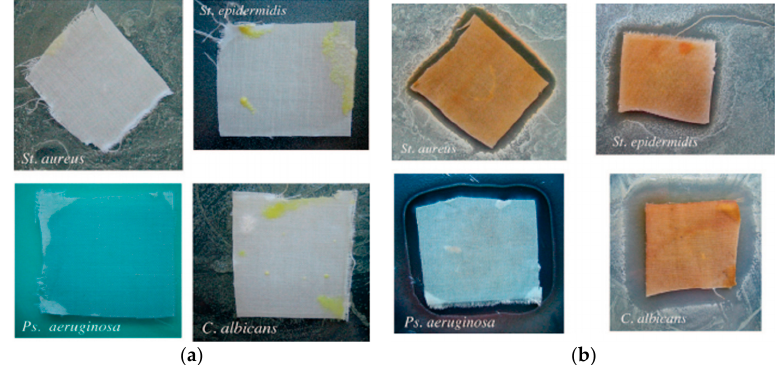
Figure 9. ( a ) Effect of untreated cotton samples and ( b ) effect of Ag-treated cotton samples toward the growth of the investigated stains. Reproduced from [83] with permission; Copyright American Chemical Society 2008.